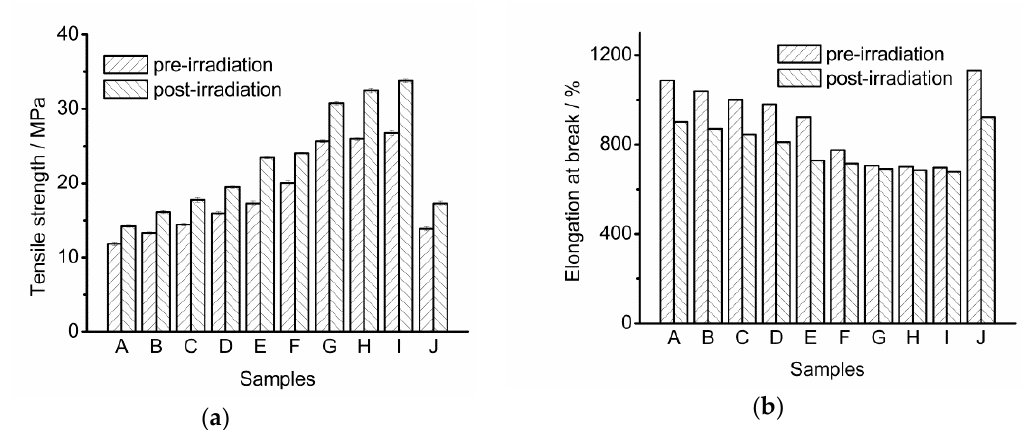
Figure 10. Tensile strength of materials pre- and post-irradiation ( a ) Elongation at break of materials pre- and post-irradiation ( b ).